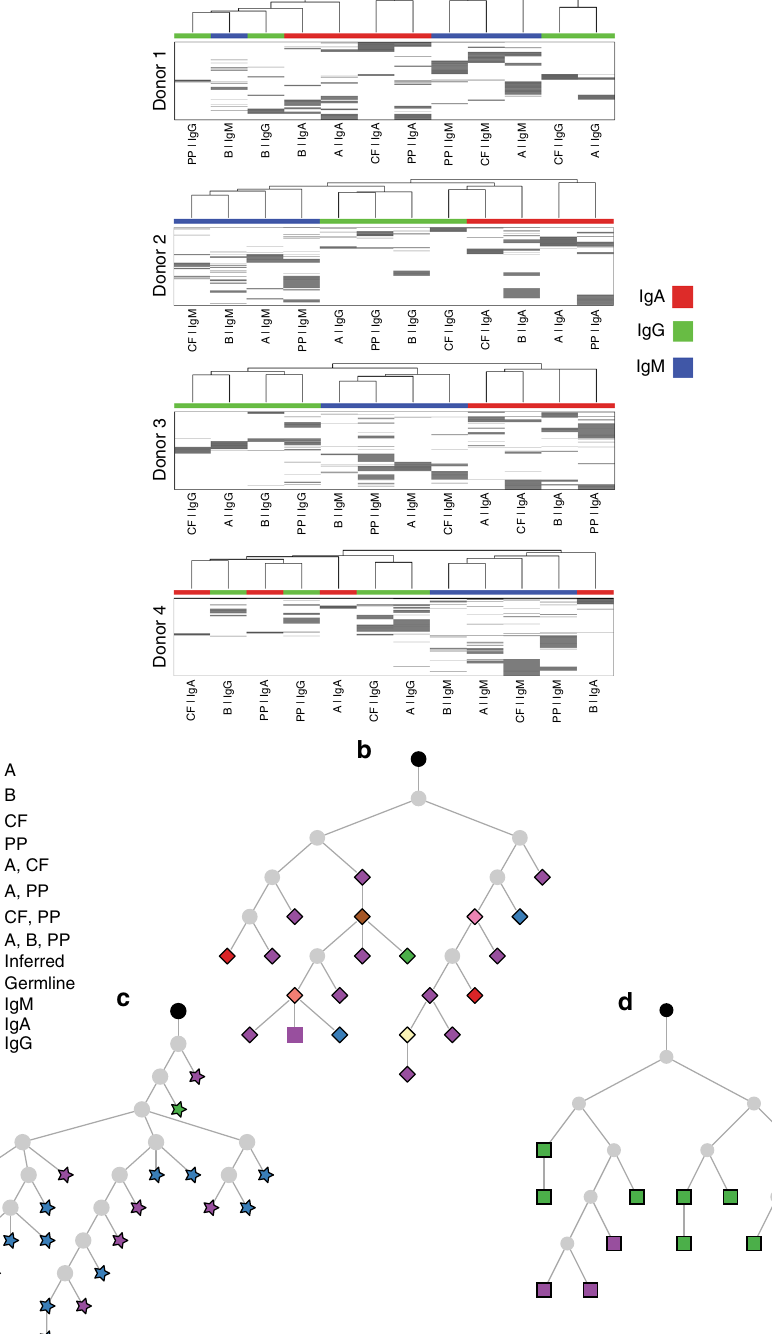
Fig. 5 Dissemination of B cell clones through human gut. Analysis of B cells from three anatomical sites from each of four tissue donors. a Hierarchical clustering of isotype-speci fi c B cell clones at different sites in the gut and blood. Each row represents a single clone, and columns represent site-isotype combinations. The grayscale represents the log 10 transformed number of unique sequences in each clone. The hierarchical clustering is based on a distance function that quanti fi es that extent of shared clones across site-isotype combinations, and is shown on the top of the heatmap as a dendrogram. b – d Lineage trees showing dispersed clones of predominantly single isotype comprised of IgA (diamonds), IgM (stars) and IgG (squares). Recombining segments and junctional sequence of the most recent common ancestor (MRCA) of the clones are: b IGHV3-30, IGHJ4*02 TGTGCGAAAAAGGTTG SGGGAGGTCCGAAAACAGAAG GGGTTGACTACTGG. c IGHV3-23, IGHJ4*02 TGTGCGAAAGGTAGCGGGTCRKCTCGCCCGTACTACTTTGACTACT GG. d IGHV5-51*01, IGHJ3*02